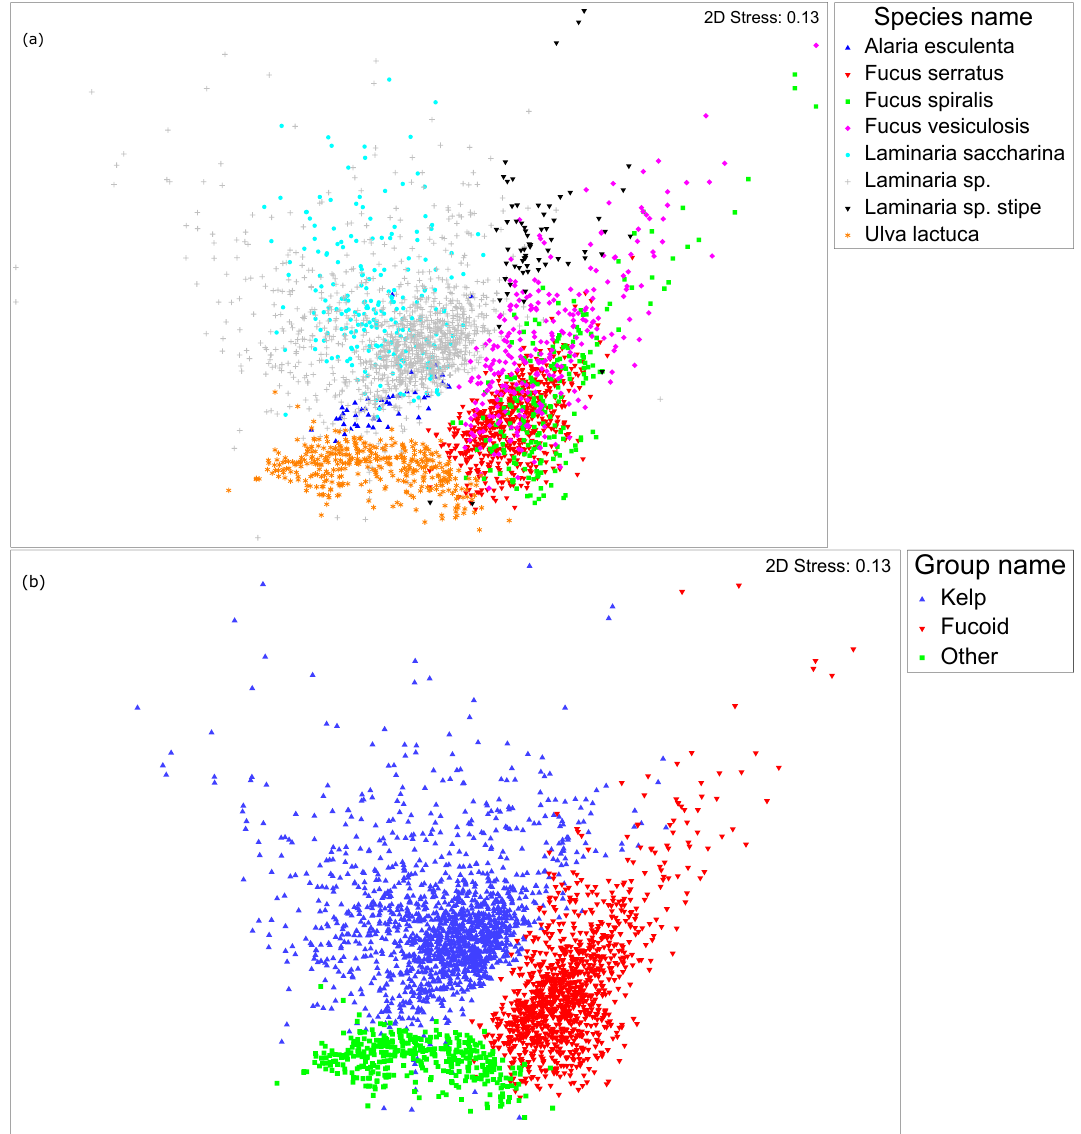
Figure 3. Non-metric multidimensional scaling (nMDS) visualizing the variance in spectral reflectance expression: ( a ) Between species. ( b ) Between